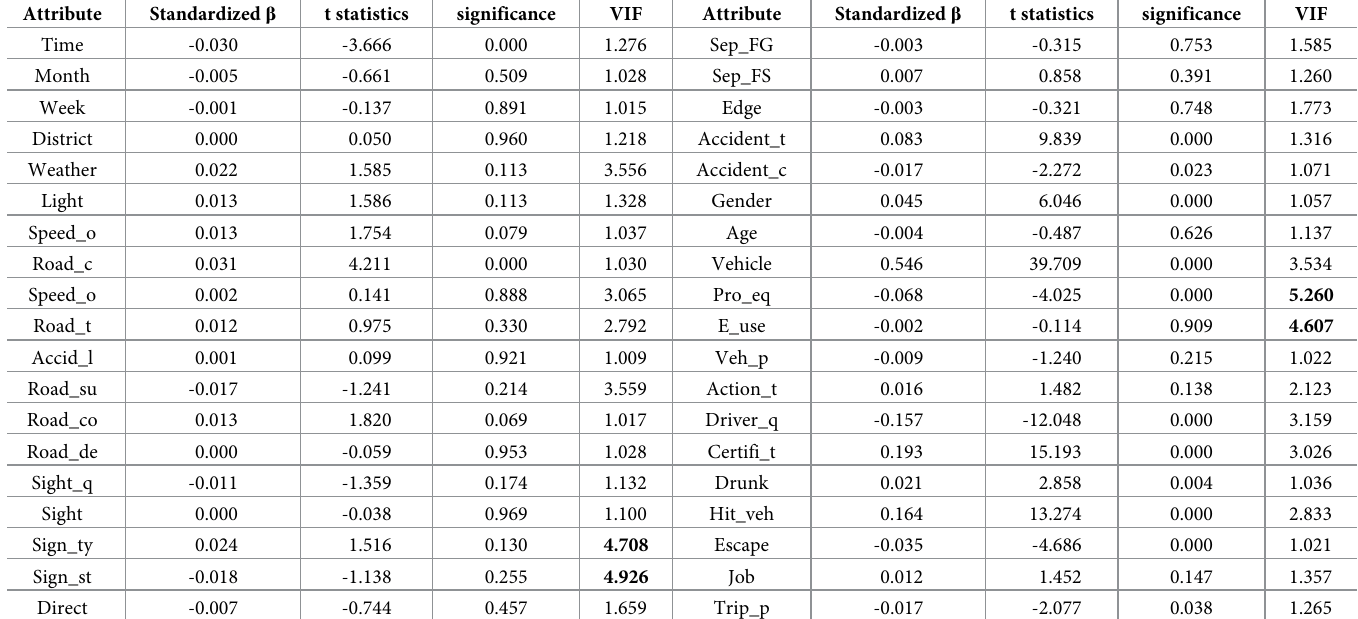
Table 6. Results of the collinearity test using VIF of multiple linear regression.